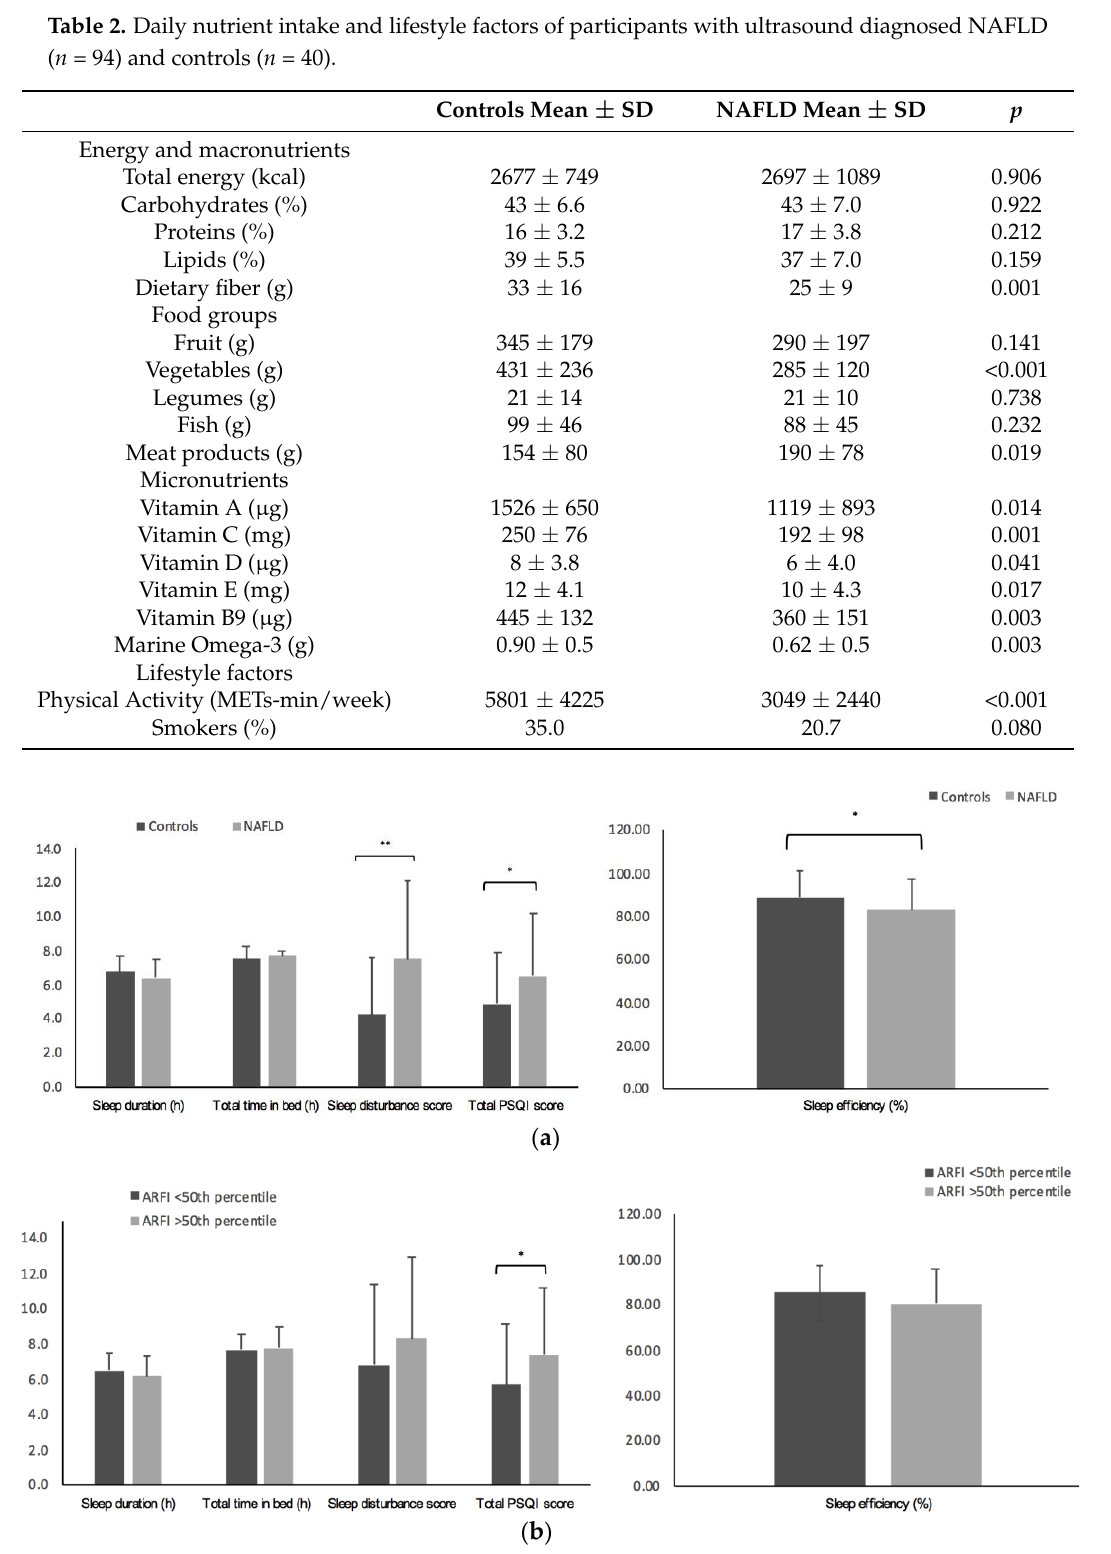
Figure 1. ( a ) Sleep characteristics of patients with NAFLD ( n = 94) and normal weight controls ( n = 40). ( b ) Sleep characteristics of patients with NAFLD and liver stiffness < 50th percentile ( n = 46) vs. liver stiffness > 50th percentile ( n = 46). Liver stiffness assessed by Acoustic Radiation Force Impulse (ARFI) elastography. Data expressed as mean ± SD CI95%, * p < 0.05, ** p < 0.01.